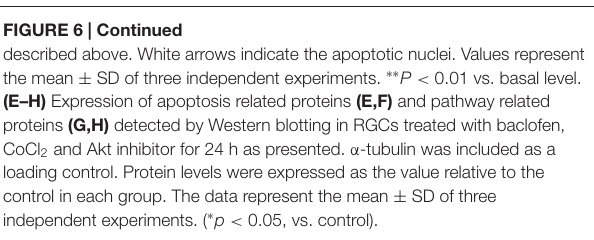
FIGURE 6 | Continued described above. White arrows indicate the apoptotic nuclei. Values represent the mean ± SD of three independent experiments. ∗∗ P < 0.01 vs. basal level. (E–H) Expression of apoptosis related proteins (E,F) and pathway related proteins (G,H) detected by Western blotting in RGCs treated with baclofen, CoCl 2 and Akt inhibitor for 24 h as presented. α -tubulin was included as a loading control. Protein levels were expressed as the value relative to the control in each group. The data represent the mean ± SD of three independent experiments. ( ∗ p < 0.05, vs. control). pathway, which is regulated by the GABA B receptor and the Akt